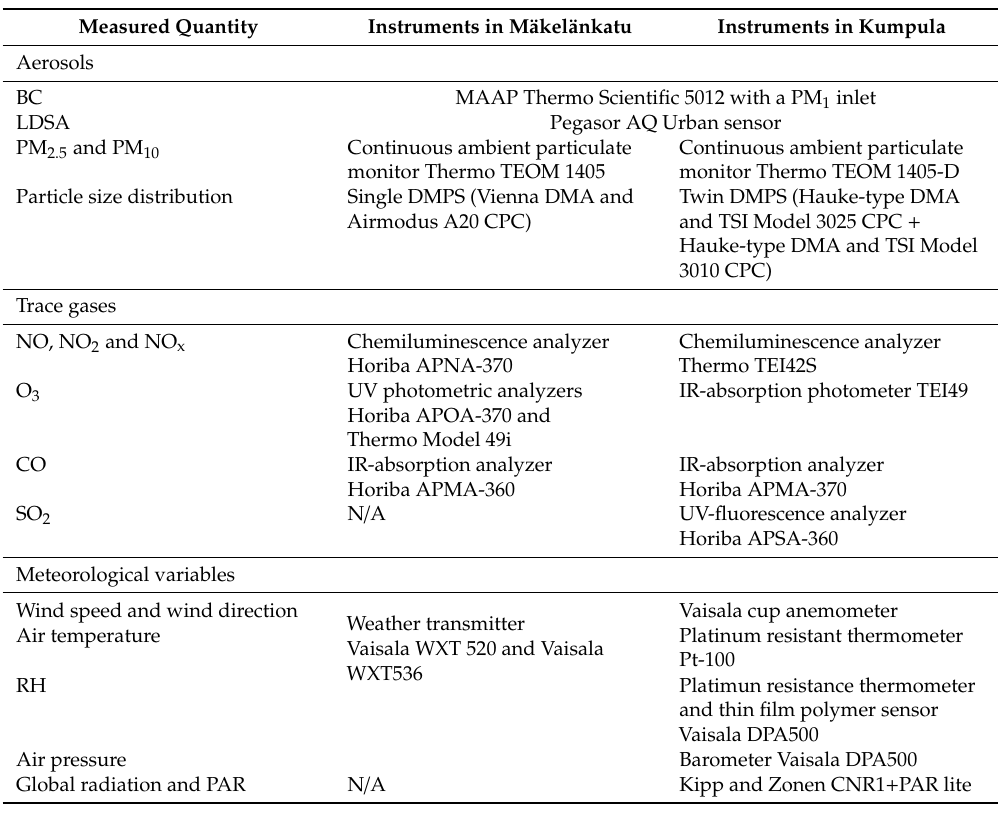
Table 1. Summary of the measured parameters and their instruments used in Mäkelänkatu and Kumpula. Same instrument was used in both locations for BC and LDSA